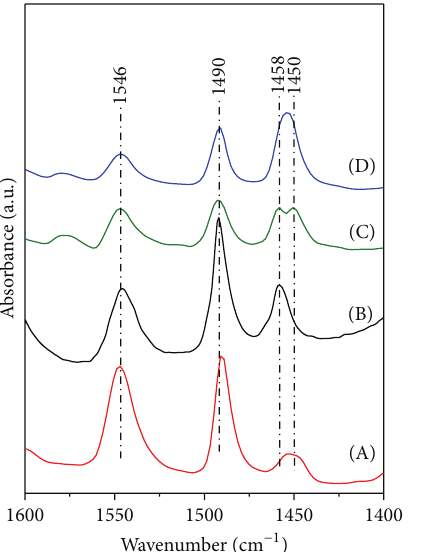
Figure 4: IR spectra of pyridine adsorption on (A) H-ZSM-5, (B) 0.5 Zn/ZSM-5, (C) 1.3 Zn/ZSM-5, and (D) 2.7 Zn/ZSM-5 at 200 ∘ C.